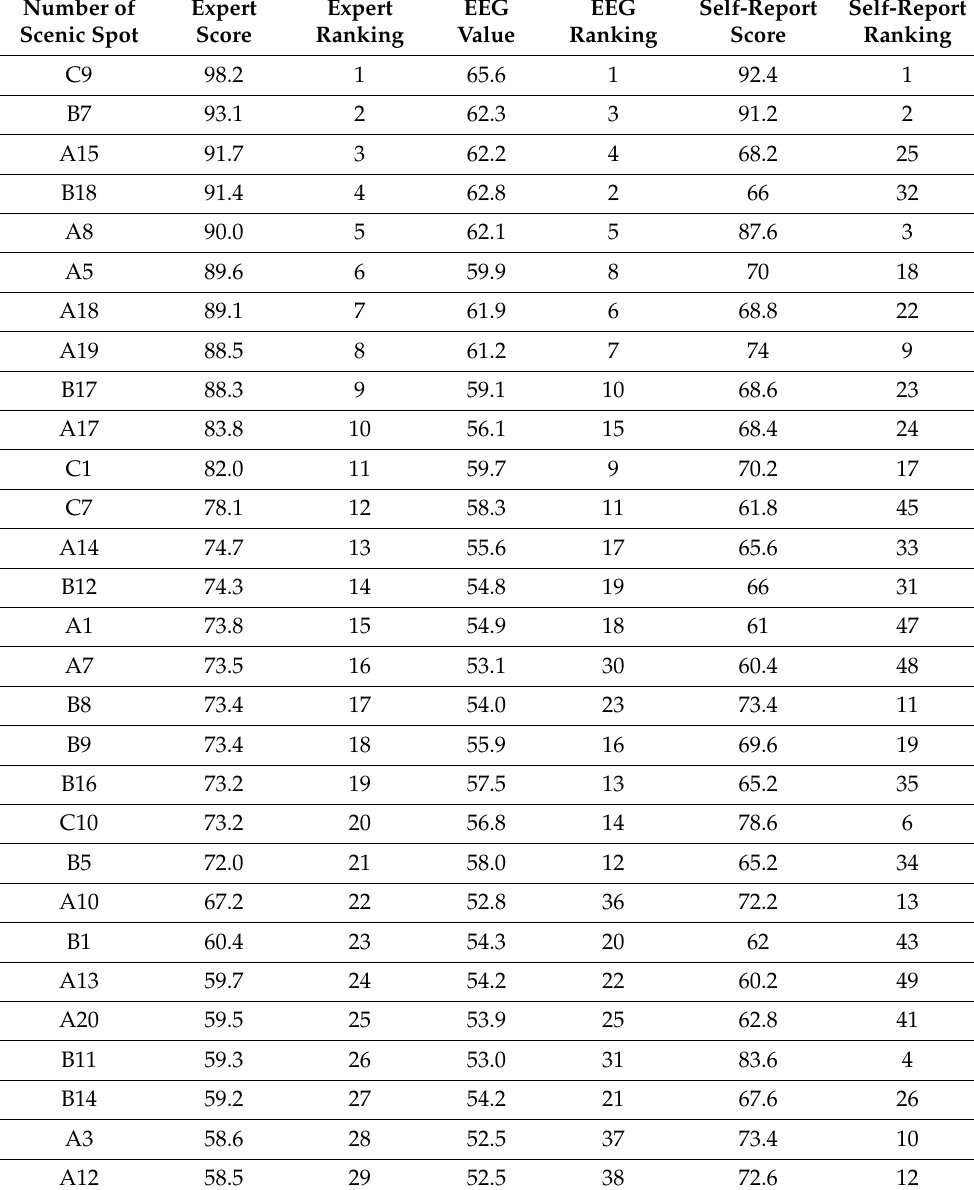
Table 4. Results of the Expert Approach, the Self-report Method, and the EEG Method. Number